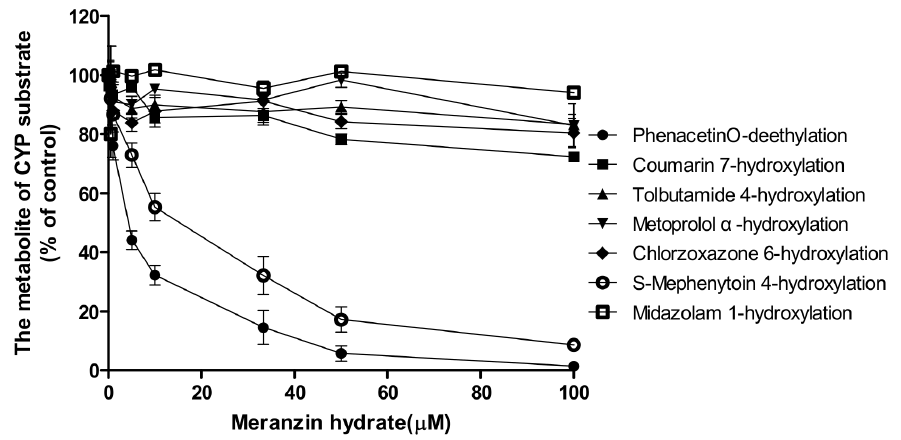
Figure 4. Effect of meranzin hydrate on the metabolic reactions of the seven CYP specific substrates in HLMs. Note: The incubation conditions are described in the materials and methods section. Each data point represents the average of triple determinations and error